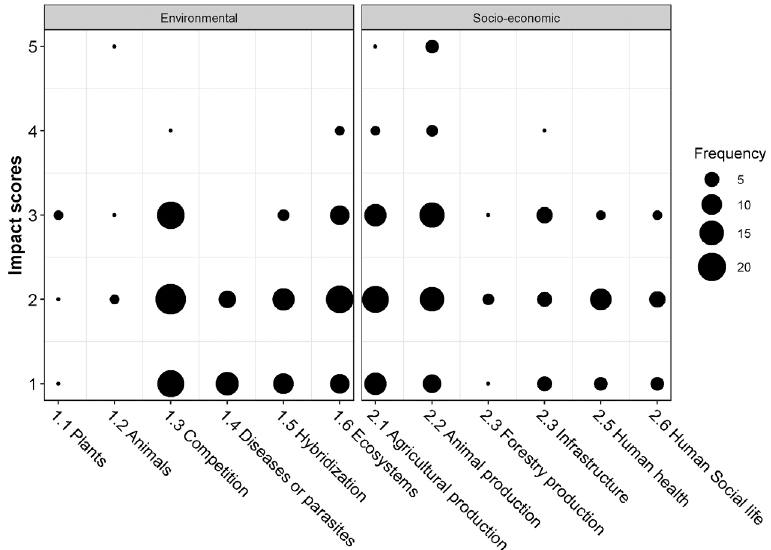
Figure 1. Number of alien grass species per impact mechanism for each impact magnitude. On the x-axis are the GISS environmental and socio-economic impact mechanisms, and on the y-axis are the impact scores according to GISS. The size of the points represents the number of species which had the corre- sponding maximum recorded impact score for that mechanism (out of the 48 species with impact records). See Suppl. material 1: Table S1 for the full details.